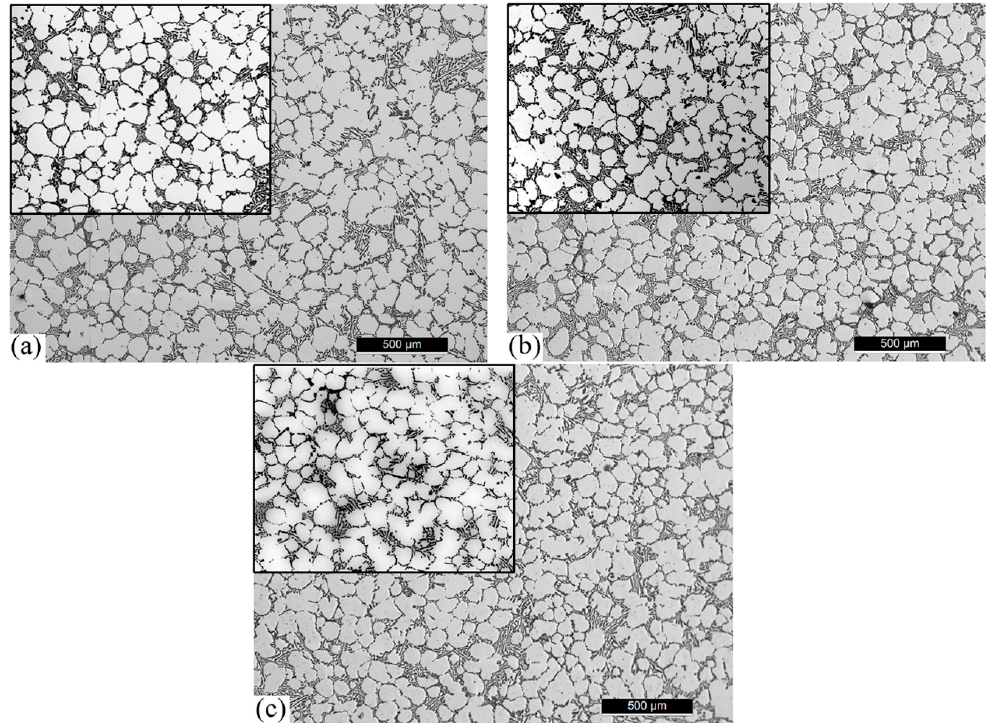
Figure 4. Examples of microstructures of AlSi7Mg0.3 alloy processed by ultrasound, at 19.9 ± 0.2 kHz average frequency evaluated in a vertical section of the feeder: ( a ) V#1; ( b ) V#2 and ( c ) V#3 samples, according to Figure 1.